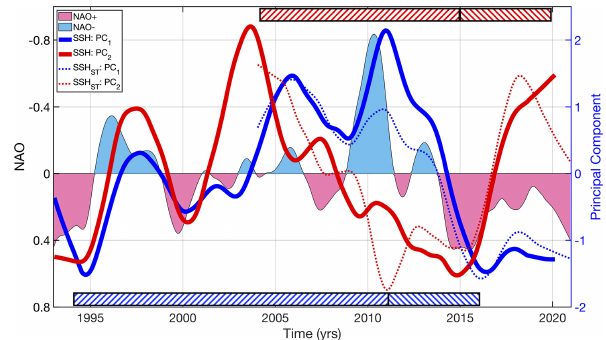
Figure 3. Time evolution (principal components) of EOF 1 (blue curves) and EOF 2 (red curves) modes of SSH (solid curves) and SSH ST (dotted curves). The low-pass-filtered monthly NAO index is shown by color shading: (pink) positive NAO and (blue) nega- tive NAO (note that the left axis for NAO is reversed). The hori- zontal bars with diagonal striped patterns indicate the time intervals used to study the relationship between sea level and surface buoy- ancy forcing (Sect. 4.5): 1994–2010 and 2011–2015 corresponding to the main tendencies in PC 1 (right and left tilted blue stripes, re- spectively), as well as 2004–2014 and 2015–2019 corresponding to the main tendencies in PC 2 (right and left tilted red stripes, respec-